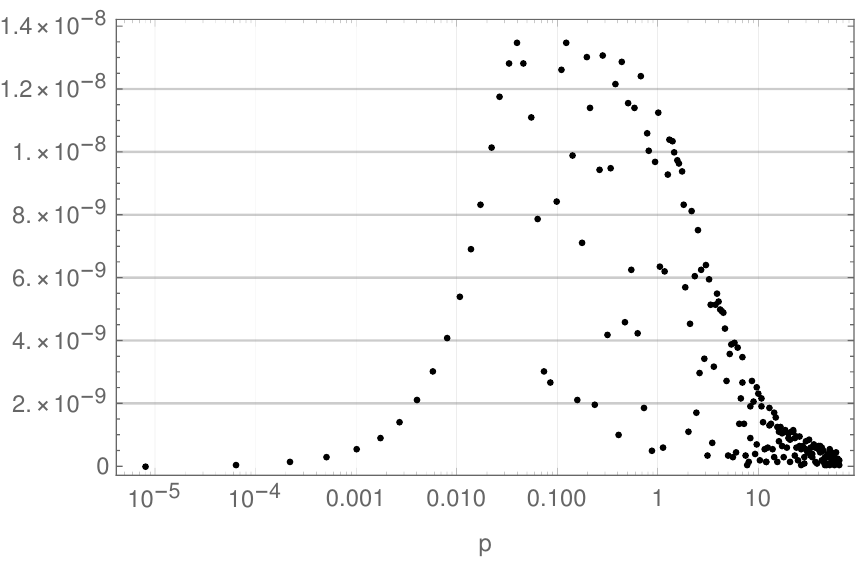
Figure 1 . The total absolute numerical error for the sum of all fermionic phase shifts computed using numerical methods compared with the analytic expressions obtained for h = 0 , h = 3 , and reported in (B.4) and